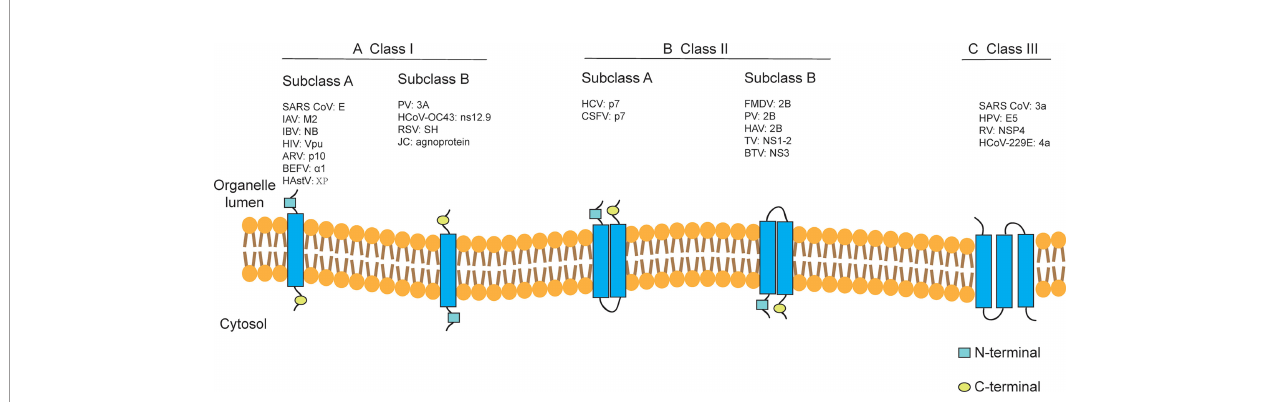
FIGURE 1 | Classi fi cation of viroporins according to the number of transmembrane domains and the membrane topology of the constituent monomers. Class I and Class II viroporins have one and two TMD, respectively. (A) Class I A viroporins have their N-termini facing the lumenal side while Class I B have their N-termini in the cytosolic side. (B) Class II A viroporins have both the N- and C-termini in the lumenal side while Class II B have them facing the cytosol. (C) Class III viroporin with three TMDs. HCoV-OC43, human coronavirus OC43; TV, tulane virus. Figure adapted from